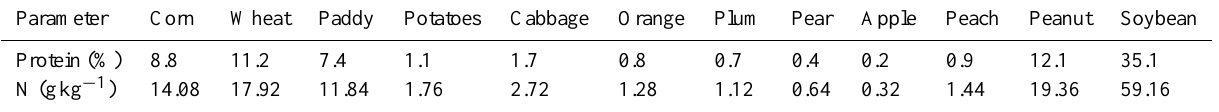
Table 2. N content of agricultural crop production (Yang et al., 2009). Parameter Corn Wheat Paddy Potatoes Cabbage Protein (%)